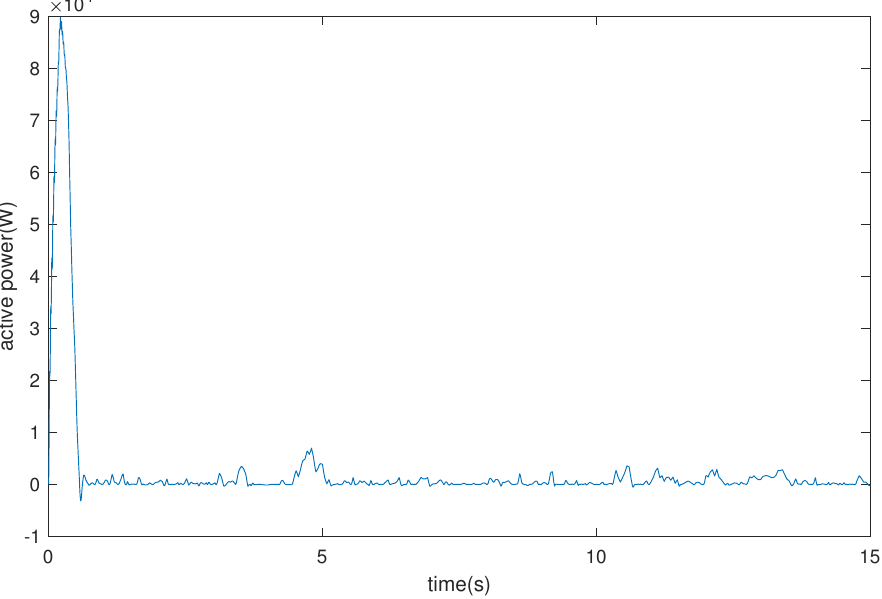
Figure 19. The active power between the PI controller and the proposed